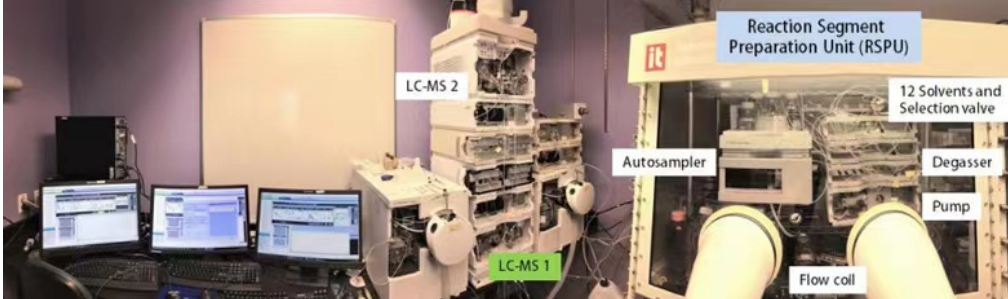
Figure 2. Pfizer’s automated high ‐ throughput chemical reaction screening platform [48].